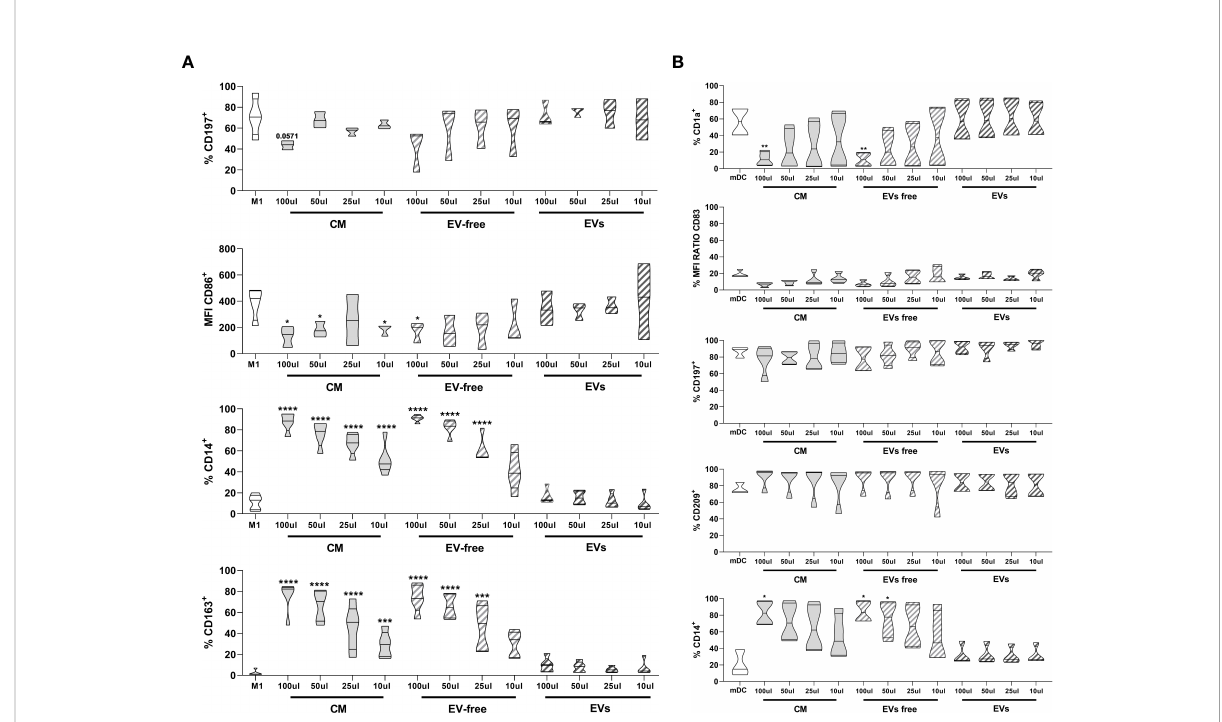
FIGURE 4 Effects of hAMSC-CM and its fractions (EV-free and EVs) on monocyte differentiation toward antigen-presenting cells (A) M1 macrophages were obtained by incubating PBMCs with GM-CSF for 4 days, followed by IFN- g +LPS for other 2 days. At the end of the culture period, the expression of CD197 and of the co-stimulatory molecule CD86, together with the pro-monocytic marker CD14, was evaluated by fl ow cytometry for M1 macrophages. The M2 polarization was assessed by analyzing the expression of the CD163 marker. (B) mDC differentiation was carried out by incubating PBMCs with GM-CSF+IL-4 for 4 days followed by 2 days of LPS treatment. At the end of the culture period, expressions of CD1a, CD197, CD209, CD14, and the co-stimulatory molecule CD83 were evaluated by fl ow cytometry for mDC differentiation. Results are presented as a percentage of expression or mean fl uorescence intensity (MFI) ratio (between MFI control and MFI treated samples) and are shown as violin plots with median (thick line) and 25th and 75th quartiles (* P <0.05, ** P <0.01, *** P <0.001, **** P <0.0001 versus control M1 (A) or mDC (B) , N ≥ 3 individual